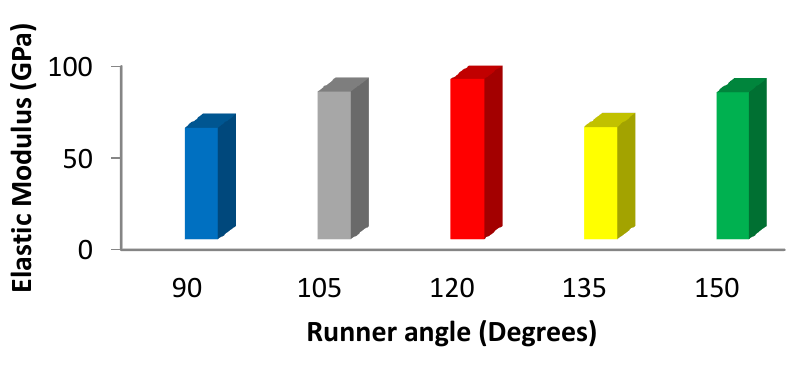
Fig. 7. Modulus of Elasticity for Al 6wt. % Cu, Al 5wt. % Zn Alloy for Varied Runner Angles.